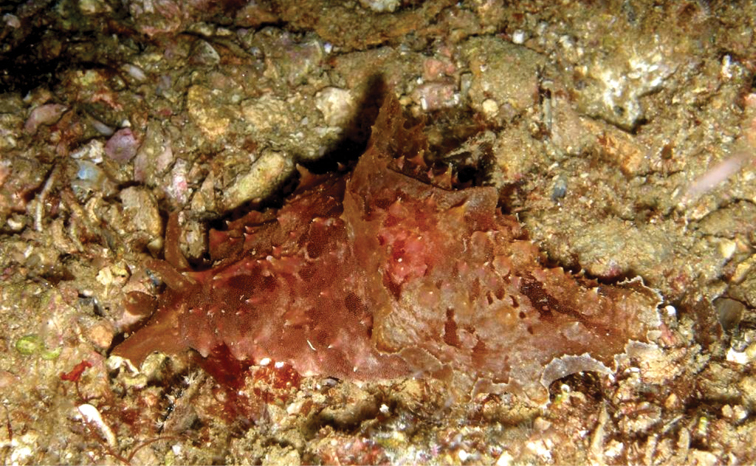
Dolabella auricularia, Oman, photo: S Kahlbrock (no spcm).